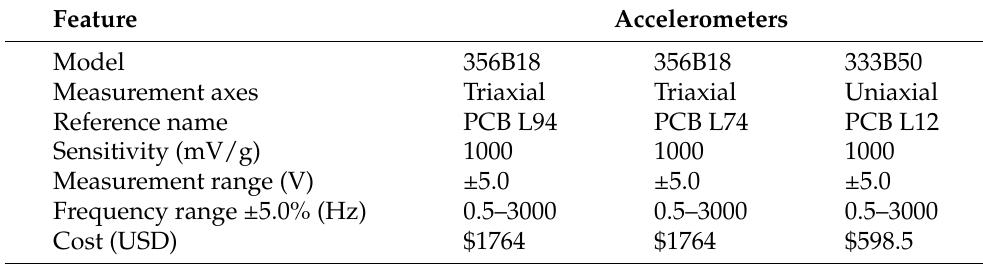
Table 2. Technique features of the PCB Piezotronics accelerometers.